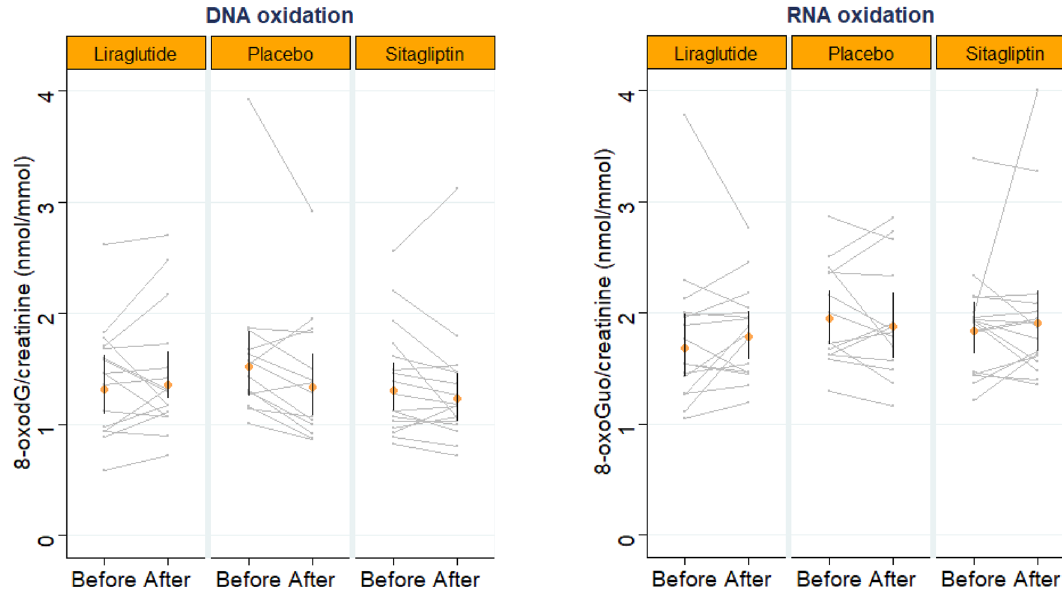
Figure 3. The SAFEGUARD study: GG-plot illustrating individual effects after 12 weeks of liraglutide, sitagliptin or placebo treatment in urinary excretion of 8-oxo-7,8-dihydroguanosine (8-oxoGuo) and 8-oxo-7,8- dihydro-2 ′ -deoxyguanosine (8-oxodG). Geometric mean with 95% confidence interval limits is